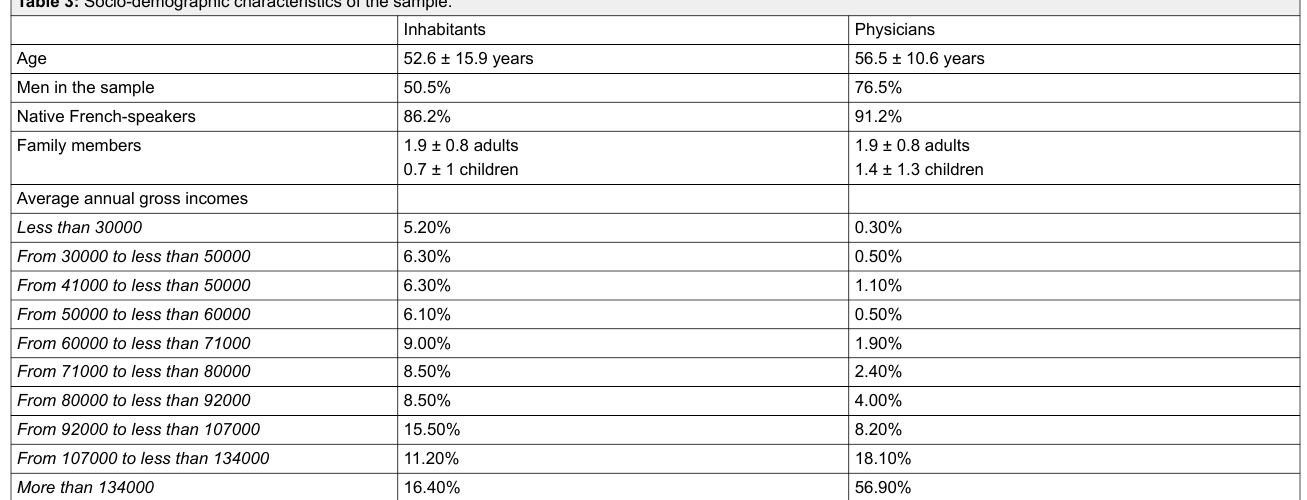
Table 3: Socio-demographic characteristics of the